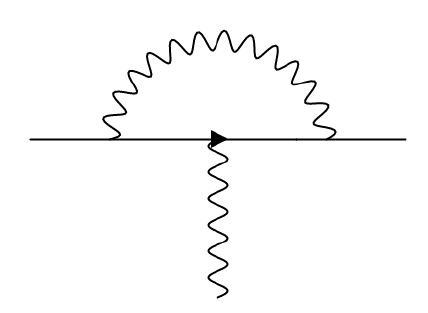
Figure 7: This is our first example of a Feynman diagram, which we will have much more to say about in section 9. The solid line represents the propagation of an elec- tron, and the squiggly line on the bottom represents the externally applied magnetic field we use to probe the system. The arcing squiggly line is a spontaneously emitted and reabsorbed virtual